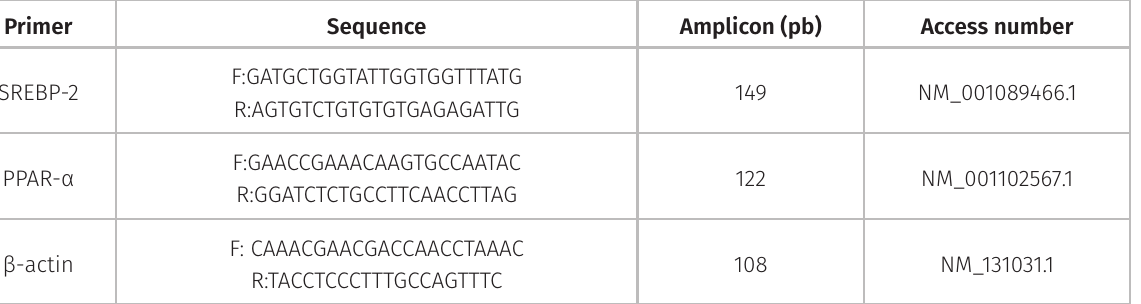
Table III. Primers used in this study. Primer Sequence Amplicon (pb) F:GATGCTGGTATTGGTGGTTTATG SREBP-2 R:AGTGTCTGTGTGTGAGAGATTG F:GAACCGAAACAAGTGCCAATAC PPAR-α